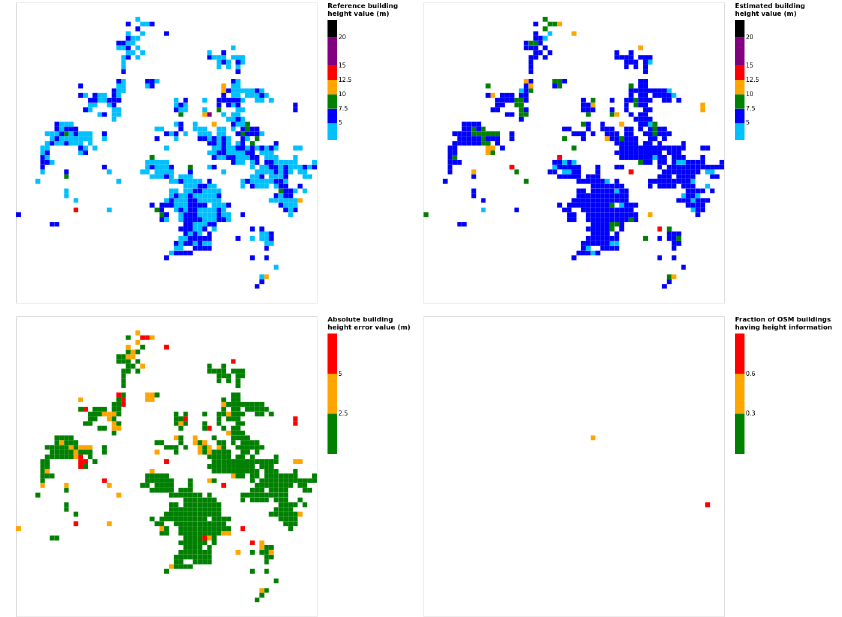
Figure B9. Results for the commune at grid cell (upper left panel) reference building height, (upper right panel) estimated building height, (lower left panel) absolute building height error, and (lower right panel) fraction of OSM buildings that have height information. For all panels except the lower right, only cells that have buildings – with at least 90% of their buildings having no height value in OSM – are displayed.